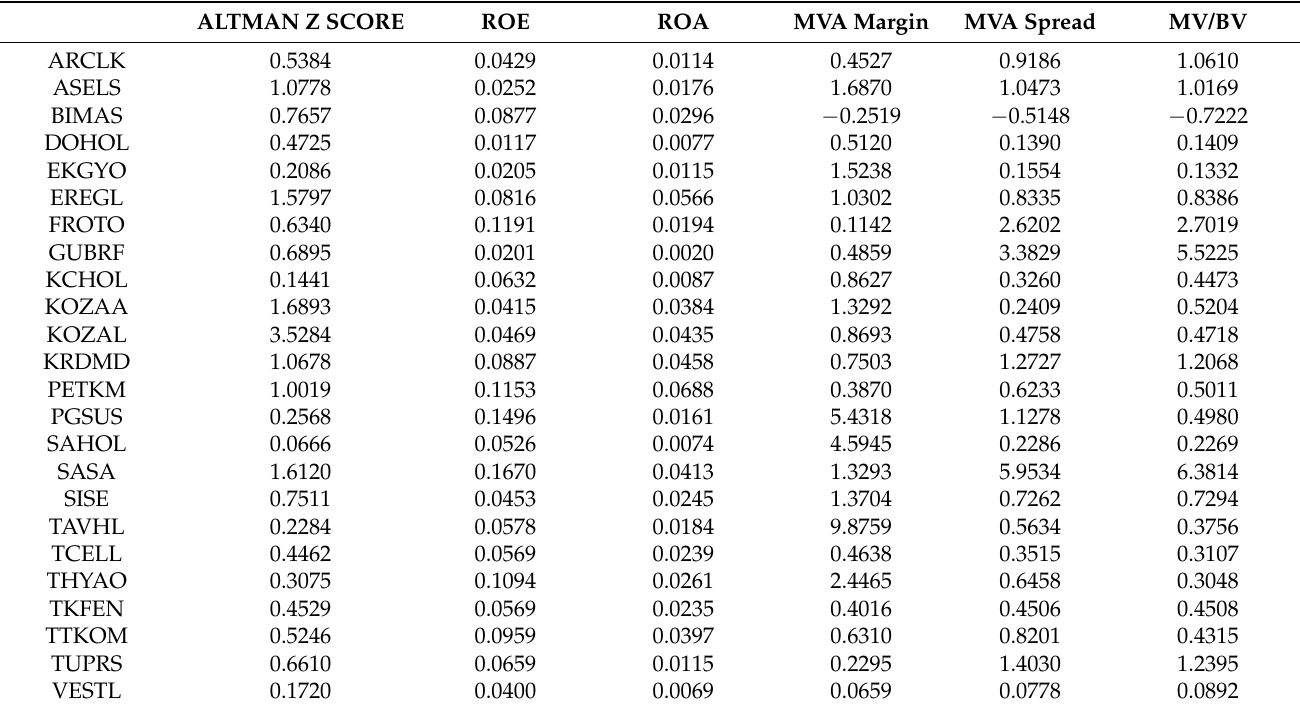
Table 5. Decision Matrix used for the MCDM Methods